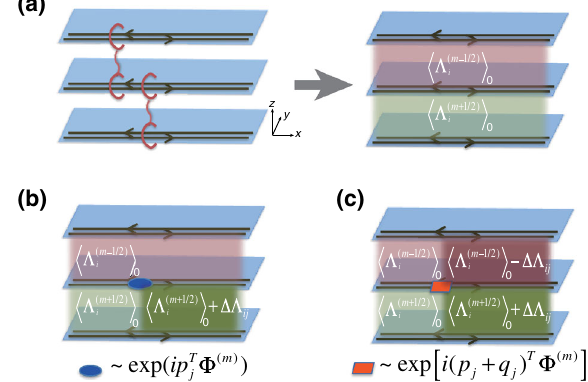
FIG. 4. (a) The condensation in the 3D bulk induces a coupling between the edge states of each layer. The side surface is effectively a coupled-wire system. In the strong-coupling limit, the vacuum expectation values h Λ m þ 1 = 2 minima determined by the cosine terms in Eq. (28). The coloring on the right-hand side indicates nontrivial but uniform h Λ m (cid:3) 1 = 2 on the side surface. (b) The operator e ip T j Φ m ð x Þ creates a collection of kinks (depicted as the change in color) in h Λ m þ 1 = 2